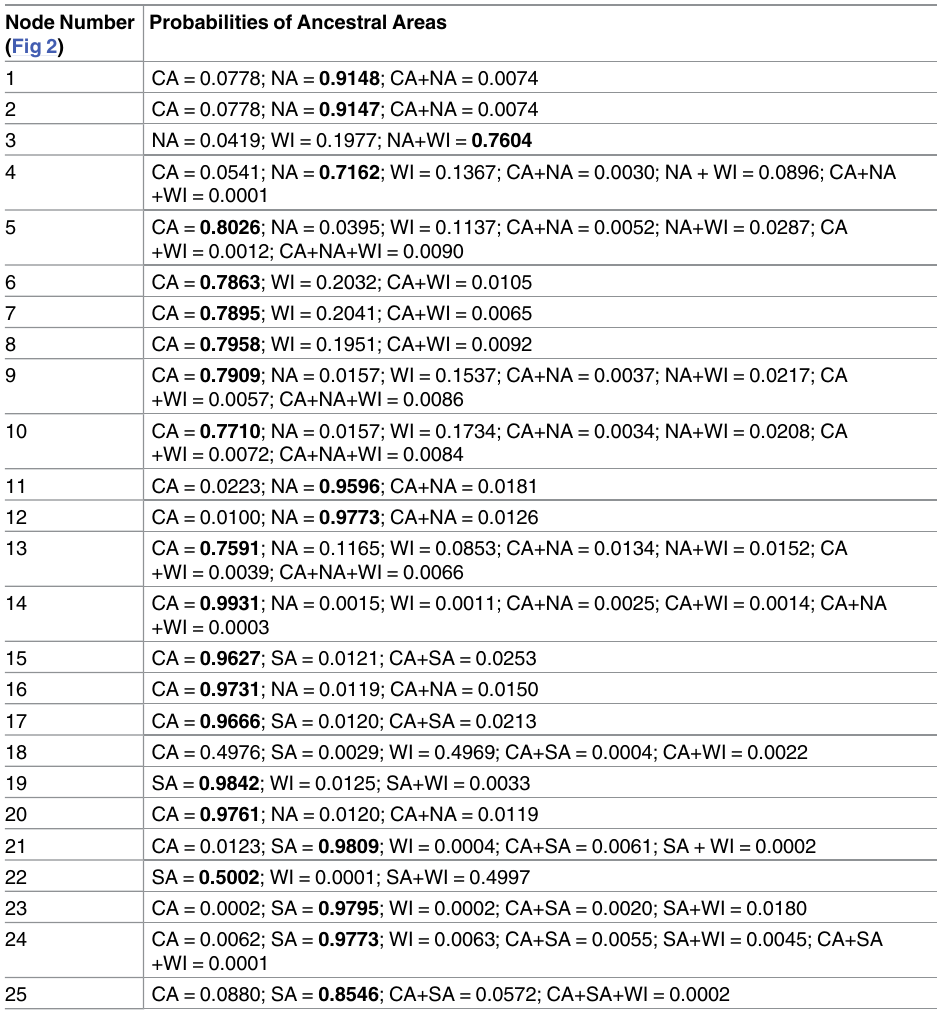
Table 3. Probabilities for ancestral ranges based on DEC + J analyses.